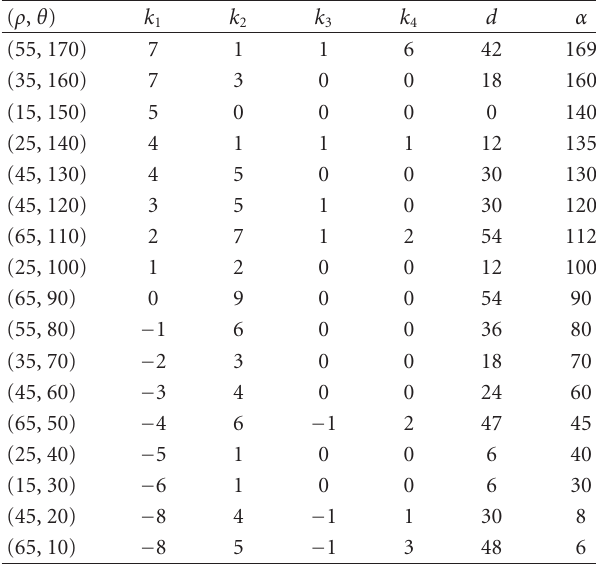
Table 3: Results of error by di ff erent neural network training.